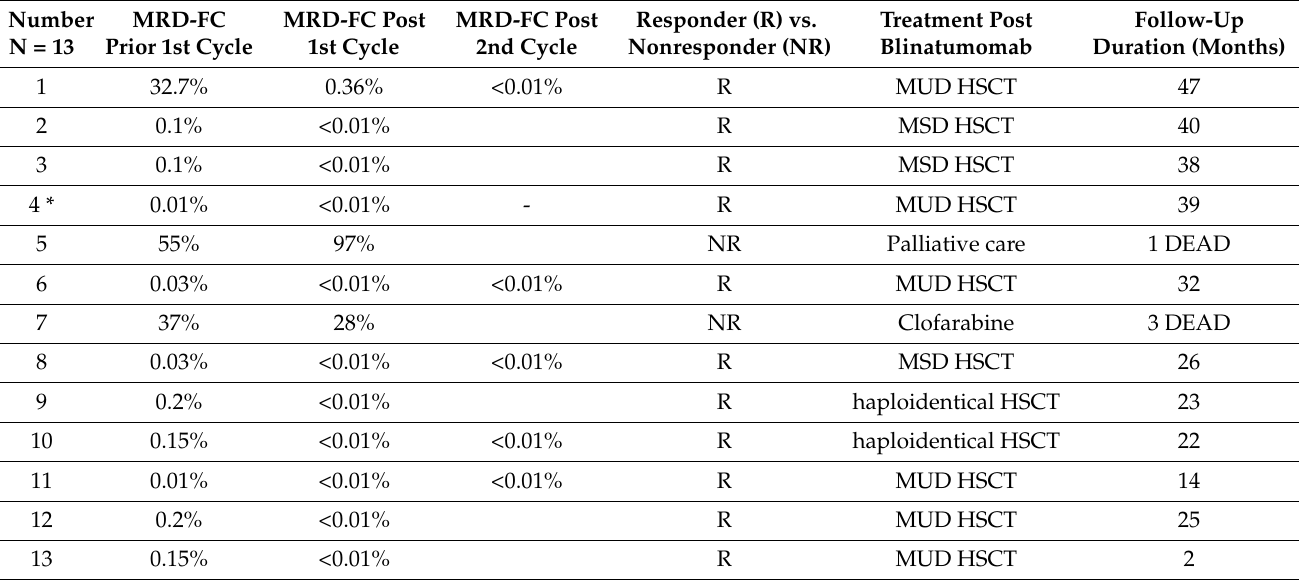
Table 3. Blinatumomab treatment outcome and MRD response.